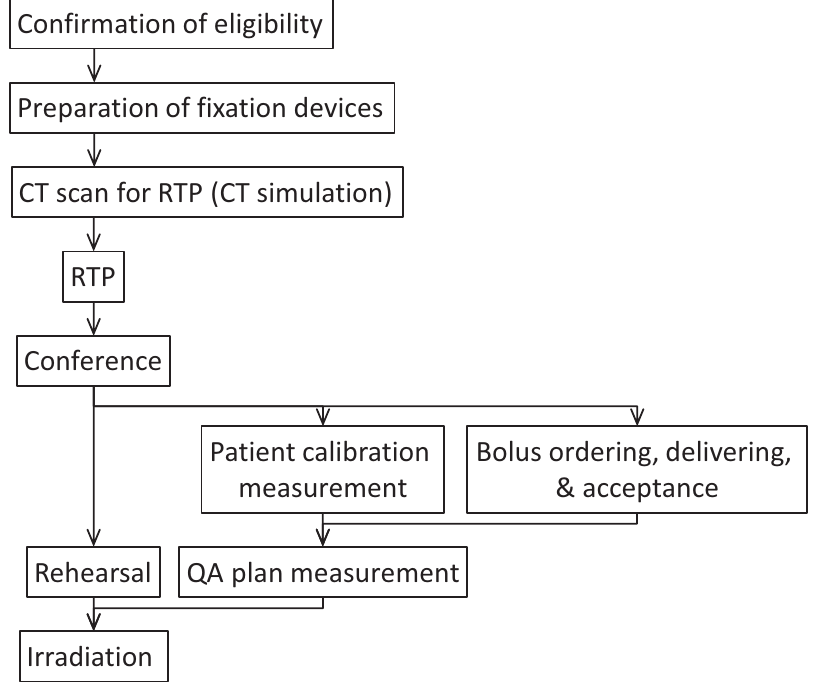
Figure 8. Typical clinical flow. RTP: radiation treatment